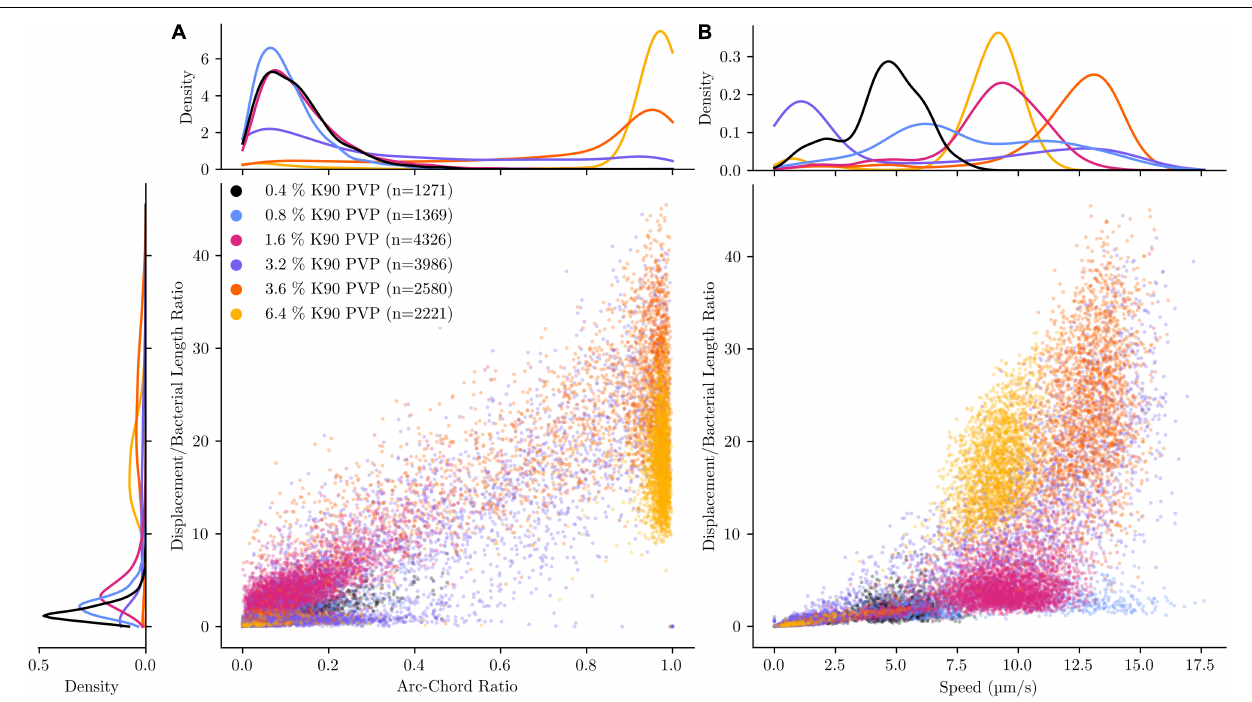
FIGURE 2 | Direct comparison of motility characteristics and statistical distribution within experiments for different PVP concentrations. The motility of C. difficile was tracked in the presence of six increasing K90 polyvinylpyrrolidone (PVP) concentrations. The PVP concentration starts at 0.4% and increase at a doubling rate up to 6.4%, with an additional step of 3.6% PVP. All observations were limited to 10 s for better comparability. Average speed (A) and arc-chord ratio ( B , denoting tortuosity of path) are plotted against the displacement/bacterial length ratio (showing the maximal distance in body lengths each bacterium has covered) for each tracked bacterium. The kernel density estimate is plotted independently for each experiment and variable, denoting the distribution for each characteristic. TABLE 1 | Median values for select properties for different PVP concentrations.